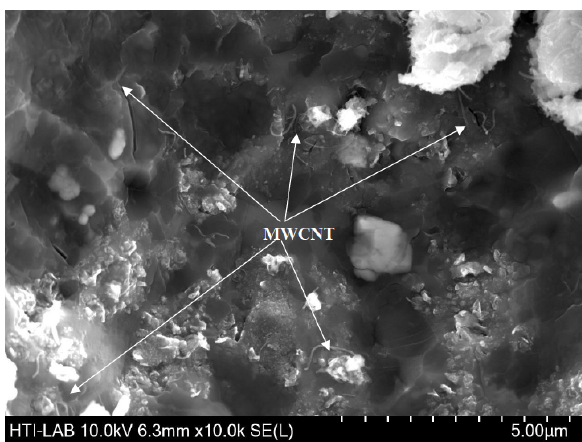
Figure 4: FESEM images of MWCNT uniform distribution in the